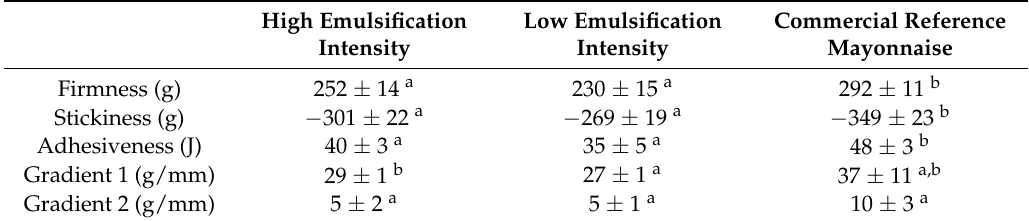
Table 6. Instrumental texture analysis as performed via a back extrusion method. Different letters in the same row indicate significant differences at p ≤ 0.05. High Emulsification Low Emulsification Commercial Reference Intensity Intensity Mayonnaise Firmness (g) 252 ± 14 a 230 ± 15 a 292 ± 11 b Stickiness (g) − 301 ± 22 a − 269 ± 19 a − 349 ± 23 b Adhesiveness (J) 40 ± 3 a 35 ± 5 a 48 ± 3 b Gradient 1 (g/mm) 29 ± 1 b 27 ± 1 a 37 ± 11 a,b Gradient 2 (g/mm) 5 ± 2 a 5 ± 1 a 10 ± 3